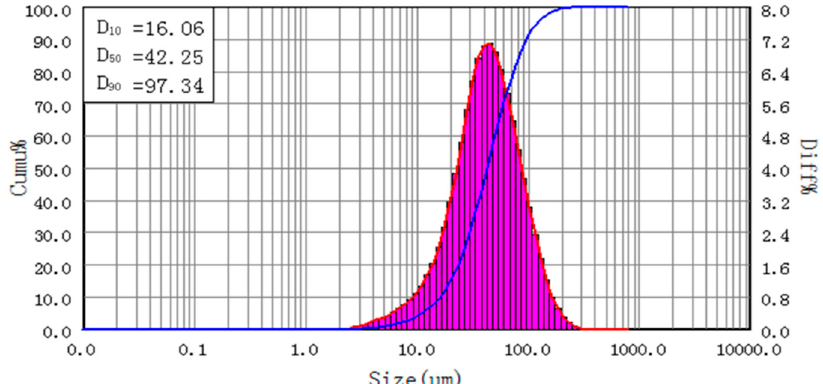
Figure 8. Particle size distribution of PVA bonded sample.